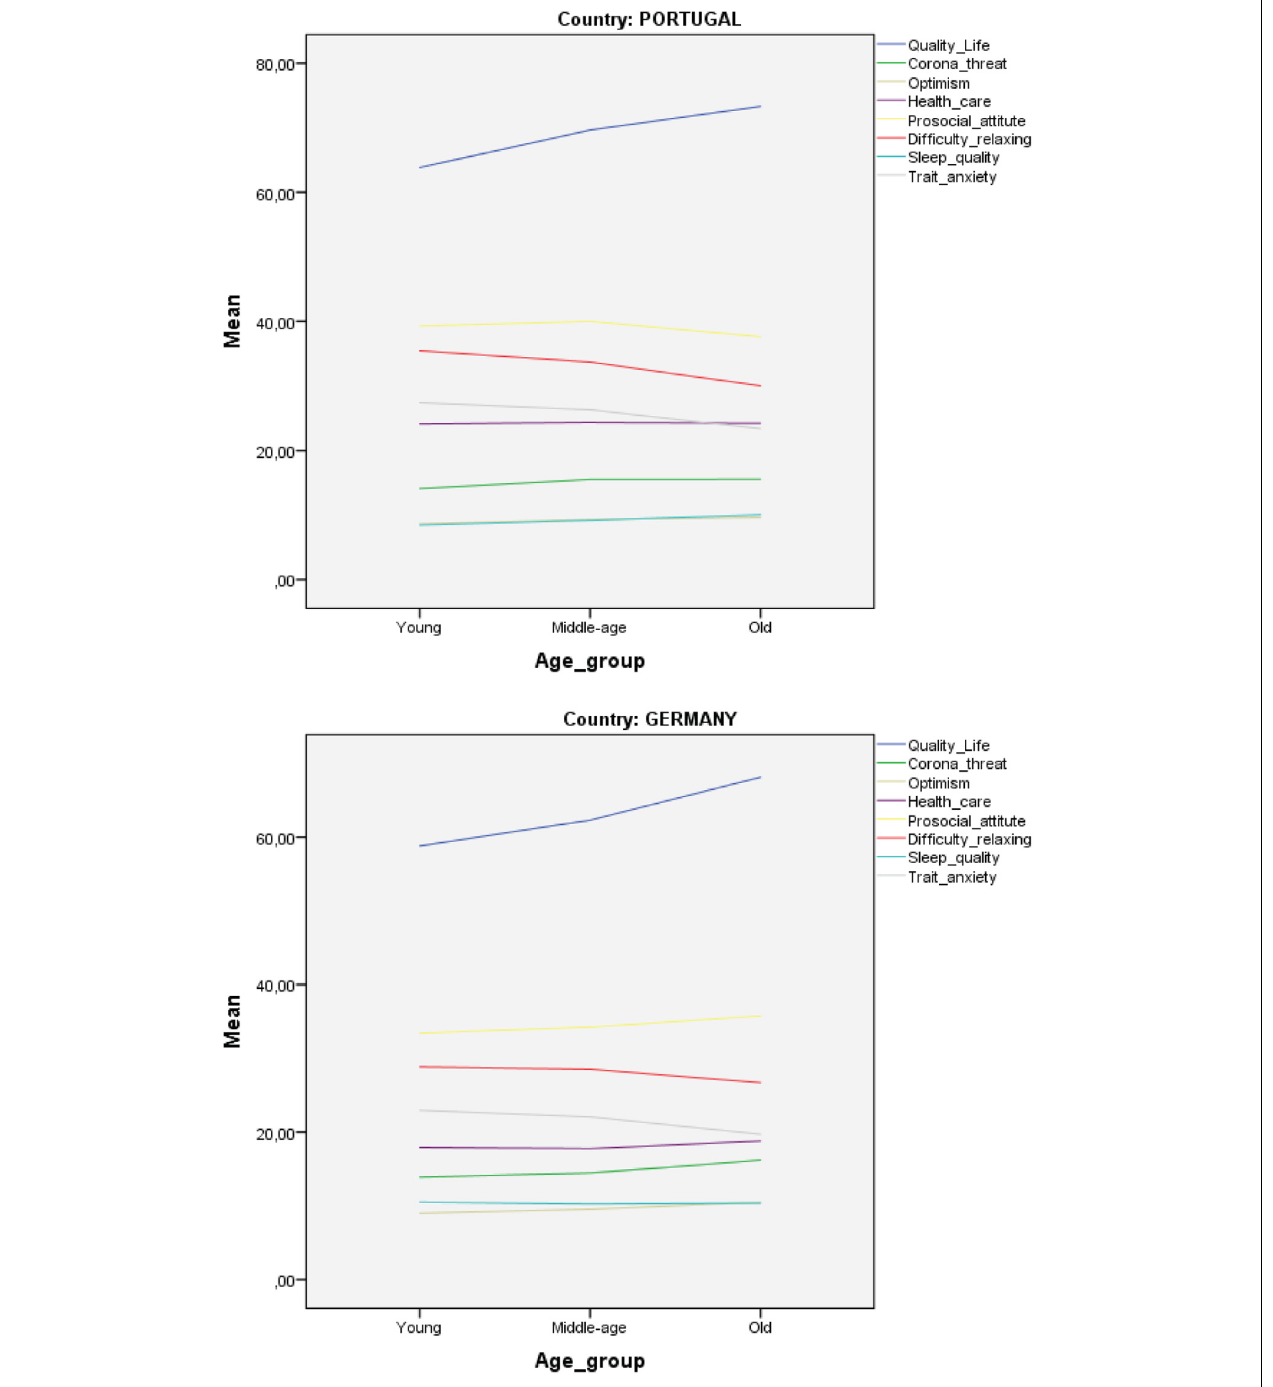
FIGURE 1 | Differences by country and group of